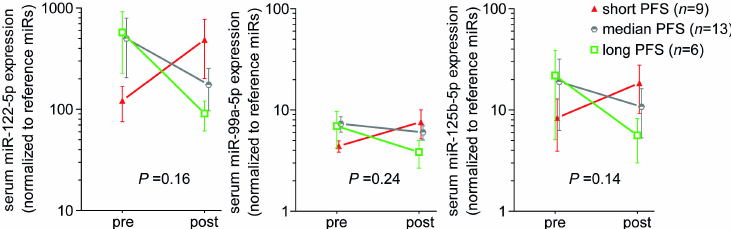
Figure 2. Pre- and post-resection expression levels of three serum miRs in PDAC patients with di ff erent PFS. Average expression levels of serum miRs 122-5p; 99a-5p or 125b-5p relative to the expression of two reference miRs, before and after surgery in three groups of patients. Short PFS in red = 0–8 months; median PFS in gray = 8–16 months; long PFS in green > 16 months. Note the log scale of the y -axis. Error bars are SEM, P -values by one-way ANOVA comparing the three patient